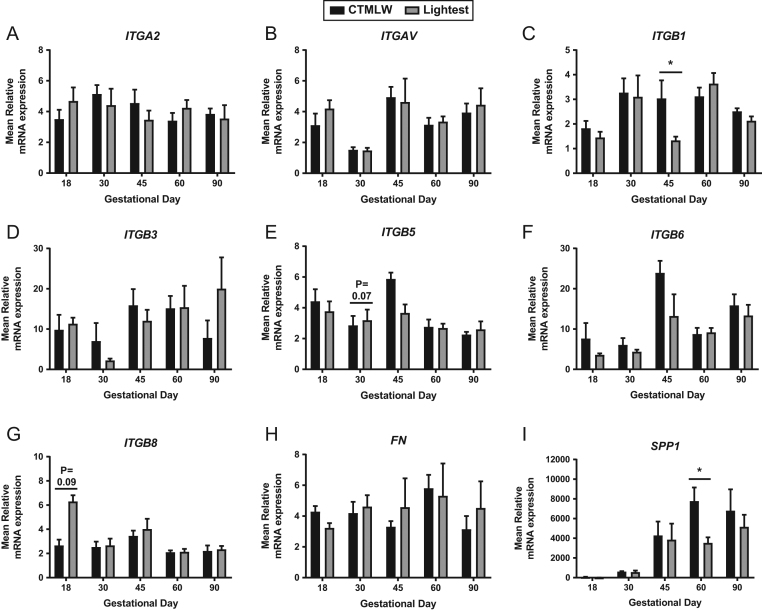
Integrin mRNA expression in endometrial tissues associated with the lightest and CTMLW conceptuses and foetuses on days 18, 30, 45, 60 and 90 of pregnancy. mRNA expression of ITGA2 (A), ITGAV (B), ITGB1 (C), ITGB3 (D), ITGB5 (E), ITGB6 (F), ITGB8 (G), FN (H) and SPP1 (I) in endometrial samples associated with the lightest and CTMLW conceptuses and foetuses at GD18, 30, 45, 60 and 90. Error bars represent s.e.m. *P ≤ 0.05. n = 3–8 foetuses/GD.